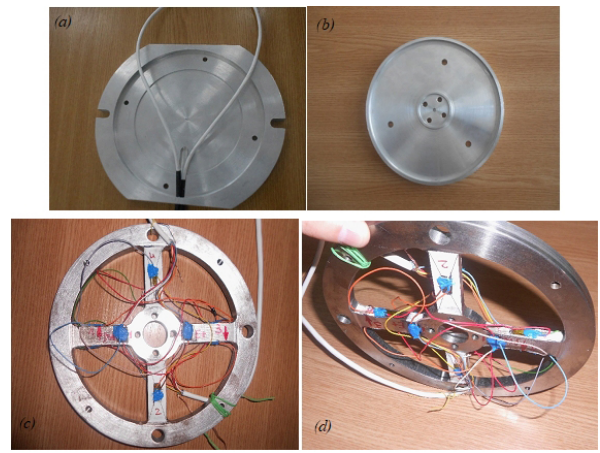
Figure 4. Aspects of the dynamometer device’s main manufactured components.